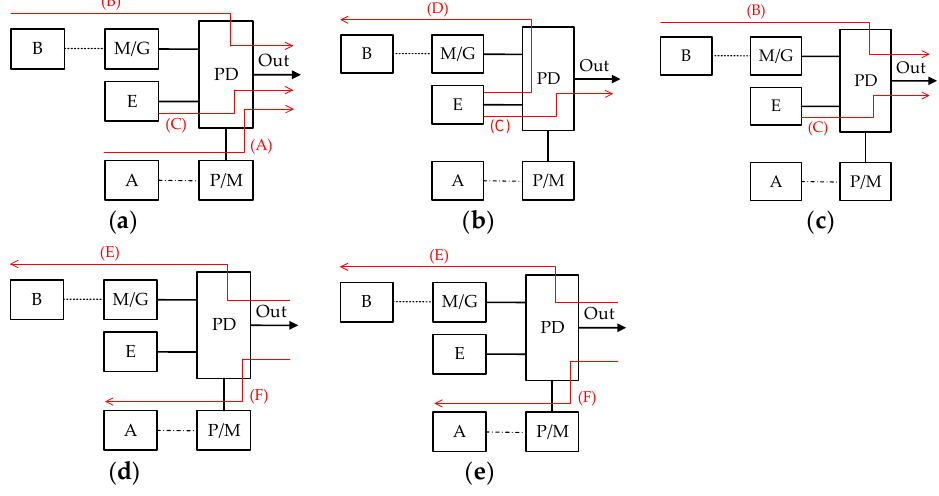
Figure 3. Power flow of the hydraulic/electric synergy vehicle (HESV) under common conditions: ( a ) start-up conditions; ( b ) urban conditions; ( c ) high-speed conditions; ( d ) braking conditions and ( e ) parking conditions.